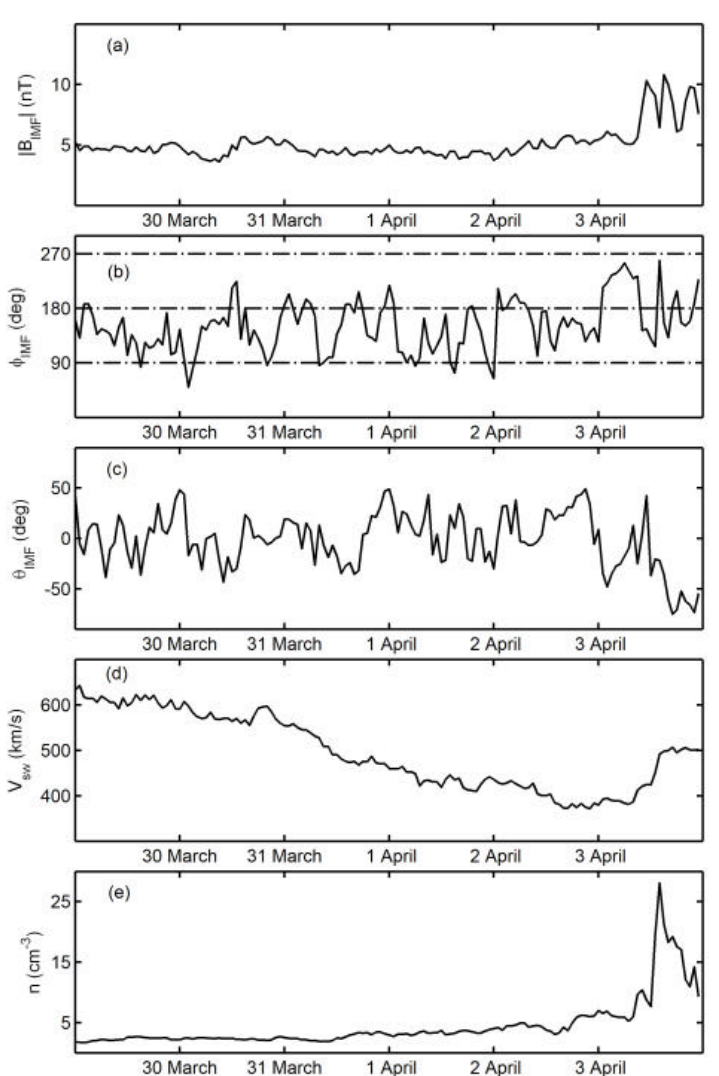
Fig. 1. Hourly averages of the interplanetary parameters as measured by ACE during 29 March–3 April 2004. Starting from the top: IMF strength, longitude (the angle between the IMF component in the ecliptic plane and the Sun-Earth direction) and latitude (the IMF inclination on the ecliptic plane), SW speed and number